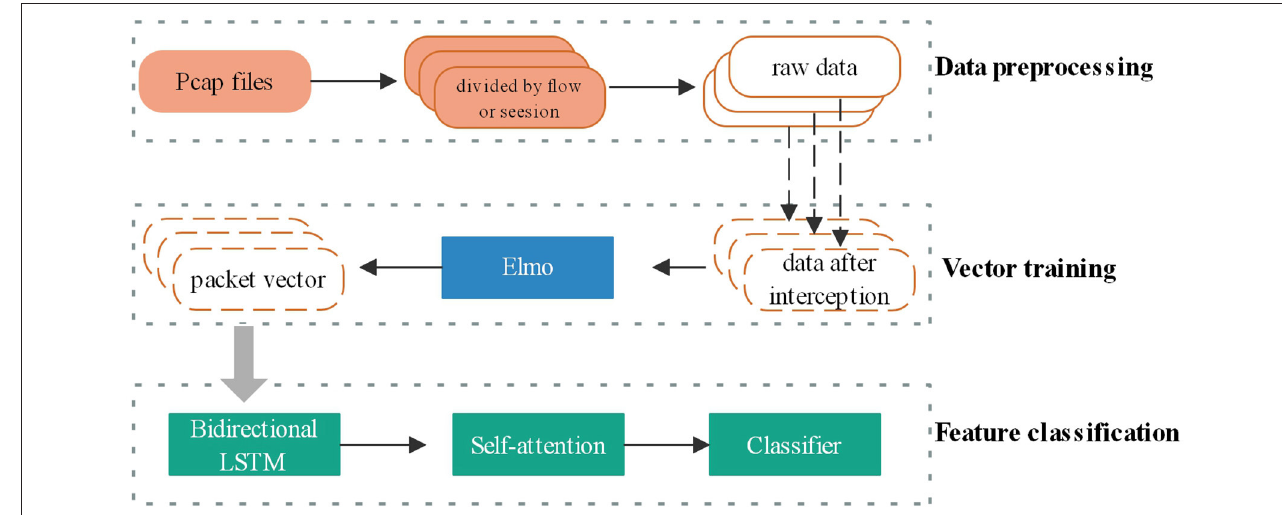
FIGURE 3 | LSTM neural network data processing